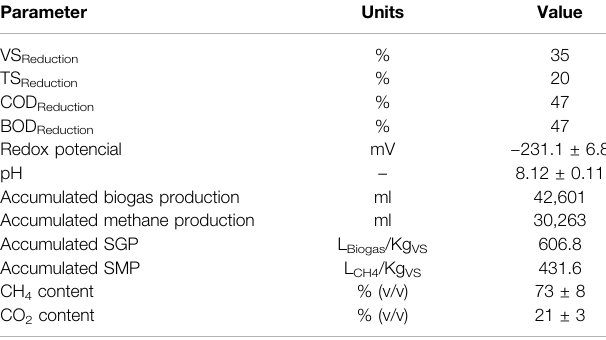
TABLE 5 | Performances of the AcoD ef fi ciency test. Parameter